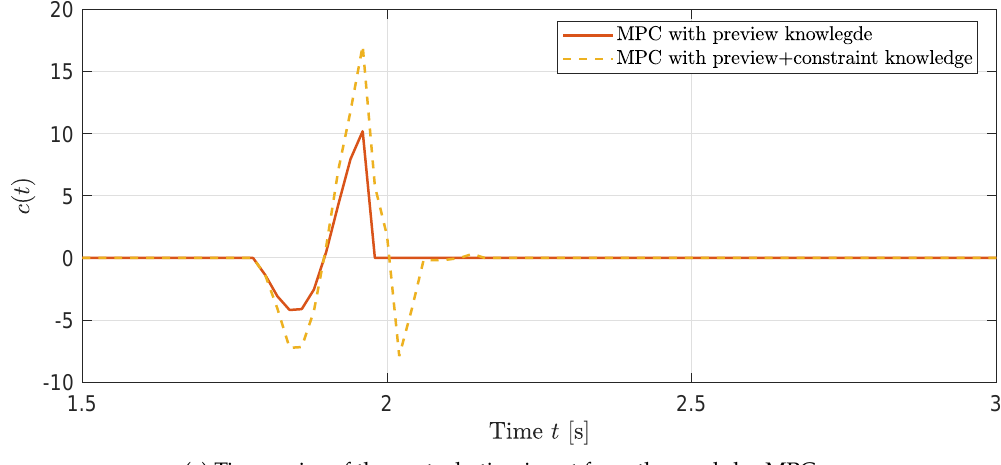
Figure 2. Time series of the output, input, and perturbation input trajectories. The thin solid (blue) lines denote the original closed-loop with the existing controller. The thick (red) solid lines represent the response of the closed-loop with the modular MPC with the preview measurement, whilst the dashed lines denote the original closed-loop with the proposed MPC module with the preview and constraint